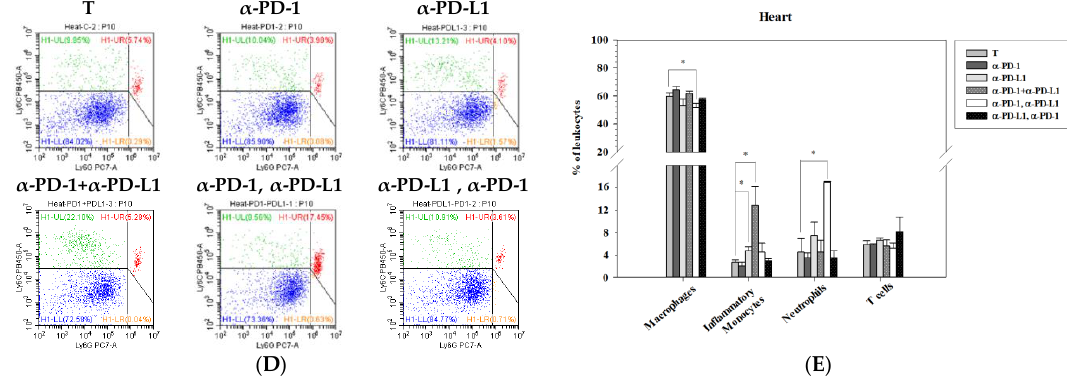
Figure 2. Combination treatment of programmed cell death 1/programmed cell death ligand 1 (PD-1/PD-L1) blockade induced myocarditis in a lung metastatic colon cancer mouse model. ( A ) Scheme of experimental design. Balb/c mice were intravenously (i.v.) injected with CT26-luciferase expressing cells. Single and combined treatment of anti-PD-1 and anti-PD-L1 were administered intraperitoneally (i.p.) on days 0, 2, and 4. Sequential treatments were administered on days 0, 2, and 4, followed by another antibody on days 6, 8, and 10. Mice were sacrificed for analysis on day 11. ( B ) Representative hematoxylin and eosin-stained (H&E) slides of heart tissues from each group (left panel: 200×; right panel: 400×). Lower panel shows the immunohistochemistry (IHC) stain of Ly6C and Ly6G expression in heart sections at 100× magnification. Scale bars indicate 100 μm. ( C ) Plasma levels of creatine kinase (CK) on 5 days, 10 days and 15 days post-treatment after immune checkpoint inhibitor (ICI) therapies. ( D ) Flow cytometric analysis of immune cell profiles from heart tissues revealed an increase of inflammatory monocytes (Ly6C ++ ) and neutrophils (Ly6G + ) in lung metastatic mice treated with concurrent and sequential PD-1/PD-L1 inhibitors, respectively. ( E ) Quantification results from flow cytometric data indicated that administration of anti-PD-1 followed with anti-PD-L1 antibodies led to the accumulation of neutrophils in the hearts of lung metastatic mice. NT and T indicate the no tumor and tumor group, respectively. In ICI-treated groups, statistical analysis was performed with the tumor (T) group (* p < 0.05). Total leukocytes (CD45 + ) = 100%. n = 3 for each group.